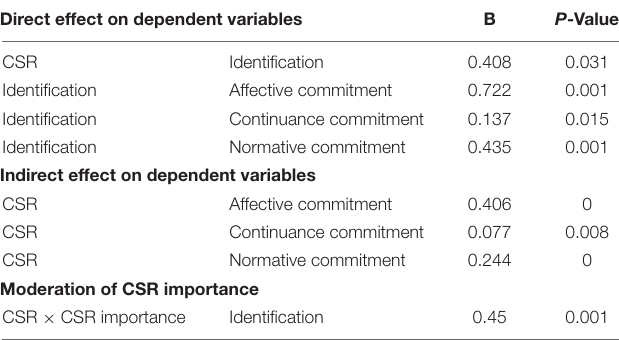
TABLE 4 | The results of path analysis of the combined